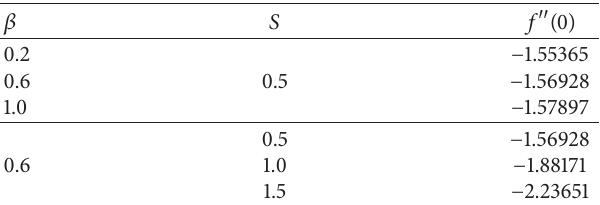
Table 2: Values of wall temperature gradient 𝜃 󸀠 (0) (for PEST case) and wall temperature 𝜃(0) (for PEHF case).